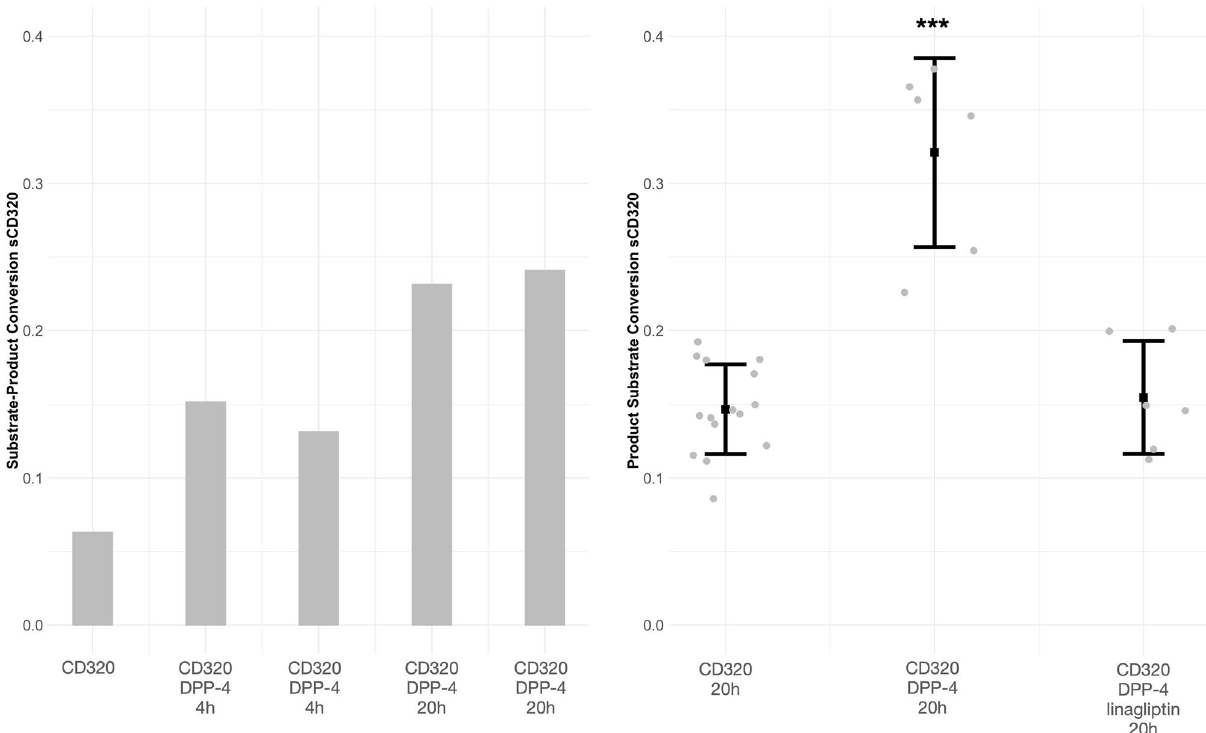
Figure 3. N-terminal processing of CD320. Substrate-product ratios of tryptic peptides derived from the N-terminal part of CD320 (CD320_36-58: SPLSTPTSAQAAGPSSGSCPPTK and CD320_38-58: LSTPTSAQAAGPSSGSCPPTK). The conversion rate in each group is given as mean + /− SD and individual data points. Left: The column bars show a time-dependent increase in conversion rate due to DPP-4 incubation time. Right: The ratio between both tryptic peptides is depicted as increase in conversion rate due to DPP-4 and inhibition of increase by linagliptin (*** p < 0.0005). DPP-4, dipeptidyl peptidase-4; sCD320, soluble form of